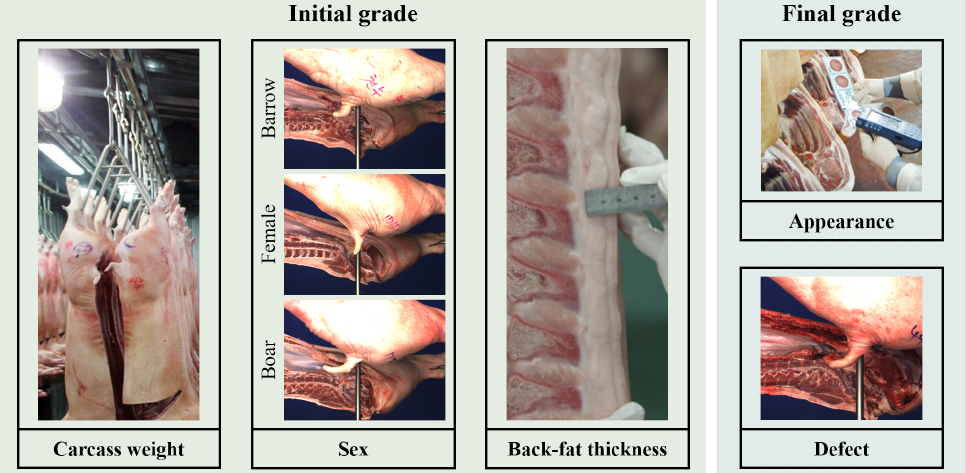
Figure 1. Main traits for grading the Korean commercial